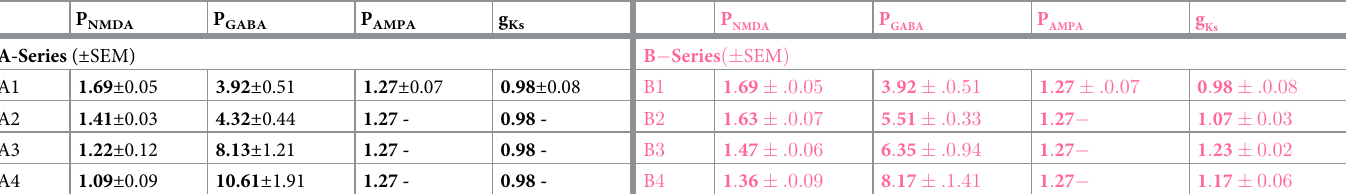
Table 1. Parameter optimization for simulated anesthetic concentrations when performed on 10 different network realizations. A/B-Series describe optimal values determined by the differential evolution algorithm fitting network connectivity parameters obtained when repeating the optimization for 10 total networks. Optimization includes A-Series, when ACh effects are assumed constant and B-Series, when ACh effects are allowed to change with anesthetic concentration. The scaling factors P x scale the effects of synaptic conductances mediated by the x receptor (x = NMDA, GABA and AMPA). A1-A4/B1-B4 denote optimal parameter sets fit to experimental record- ings at varying anesthetic concentrations (0%, 2%, 4%, 6% desflurane, respectively). P AMPA is only fit for the 0% anesthetic case A1/B1. Error displayed is SEM. P